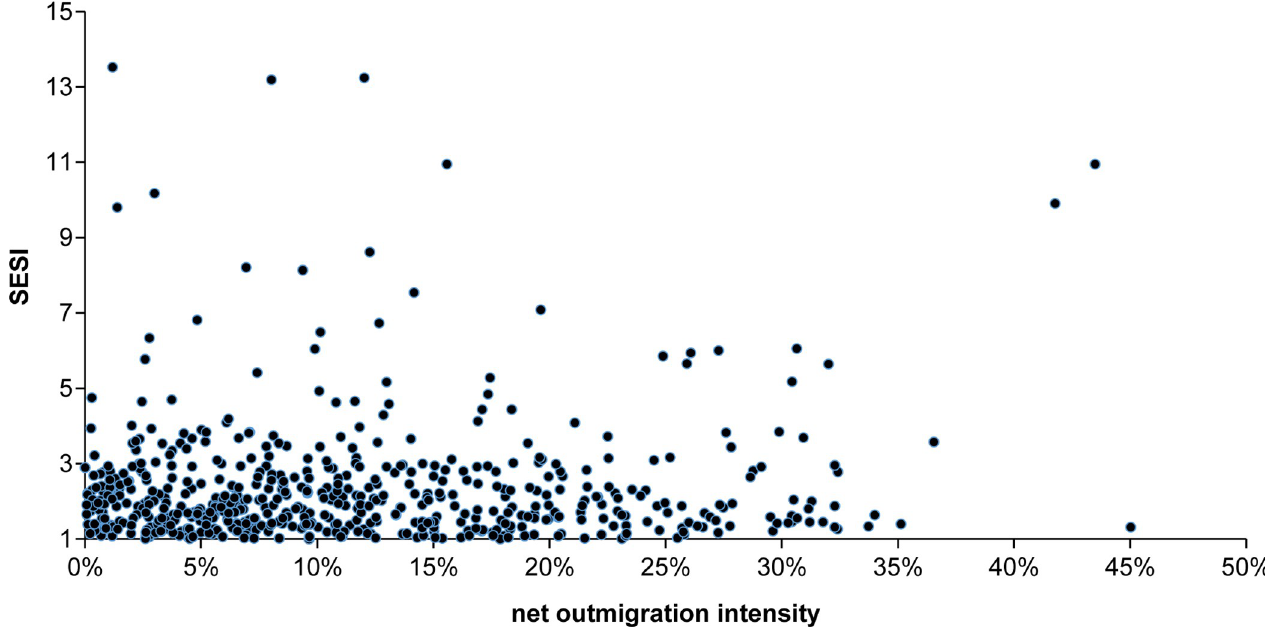
Fig 6. Scatterplot of the net outmigration intensity versus the soil erosion severity index (SESI) of counties with both.